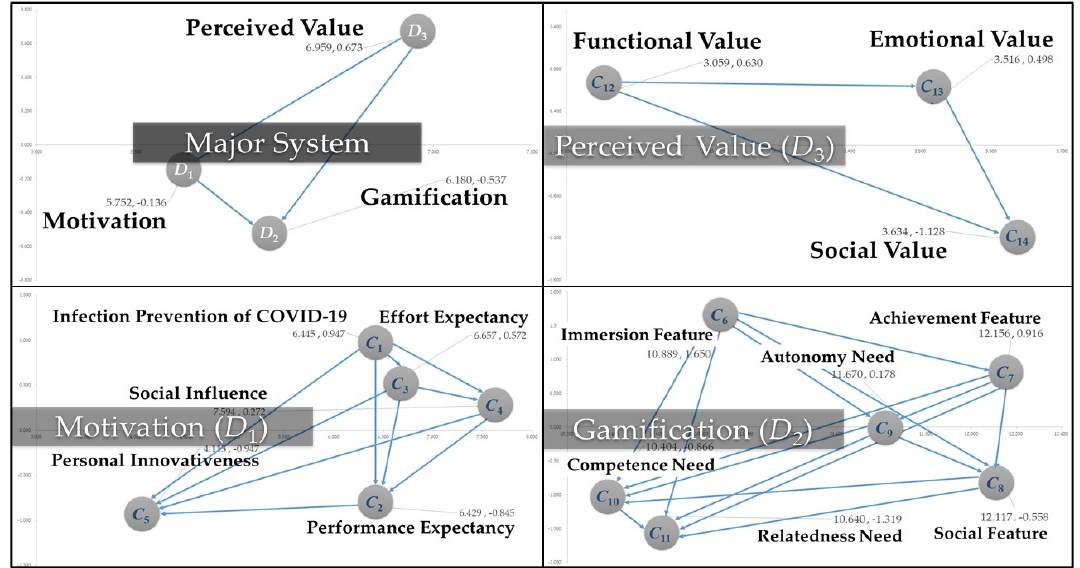
Figure 4. INRMs of the dimensions and criteria.